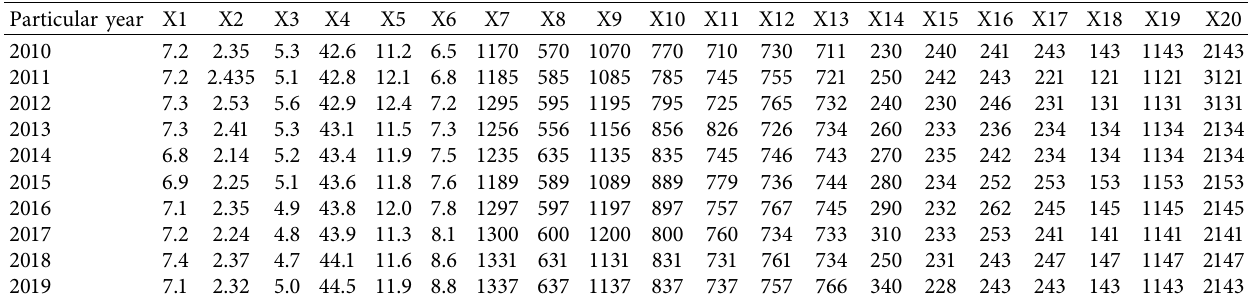
Table 2: Evaluation index values of reducing consumption of